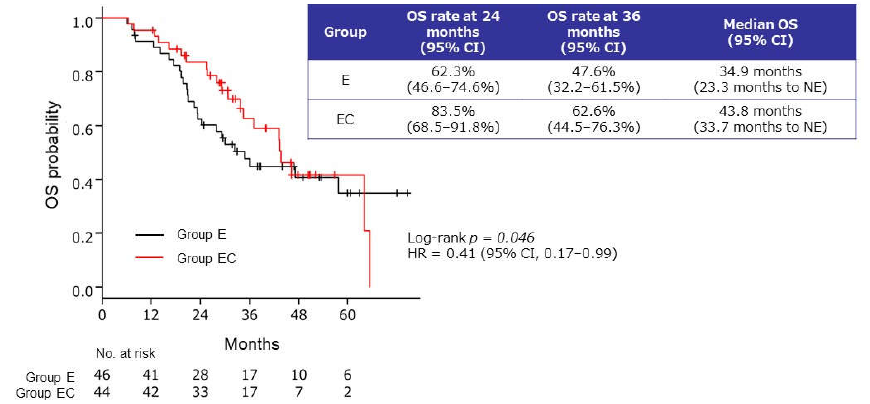
Figure 5. Kaplan–Meier curves of overall survival (OS) rate from the start of bevacizumab–paclitaxel induction therapy in patients who received maintenance therapy with endocrine therapy alone (group E) or endocrine therapy plus capecita- bine (group EC). CI, confidence interval; E, endocrine therapy alone; EC, endocrine therapy plus capecitabine; HR, hazard ratio; NE, not